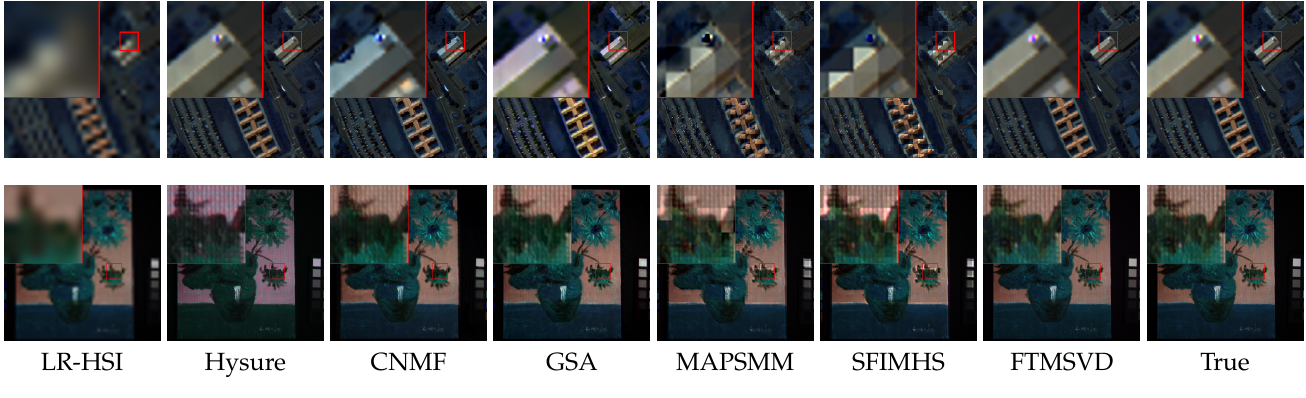
Figure 6. The first row shows LR-HSI, fusion images, and ground truth images’ false-color images in Pavia university data set (formed by bands 30th, 60th, and 90th). The second row shows LR-HSI, fusion images, and ground truth images’ false-color images in CAVE data set (formed by bands 10th, 19th, and 28th). All fusion images and LR-HSI are obtained using SRF1 and PSF1. Table 5. Average quantitative results of the blind methods on the Pavia University data set.